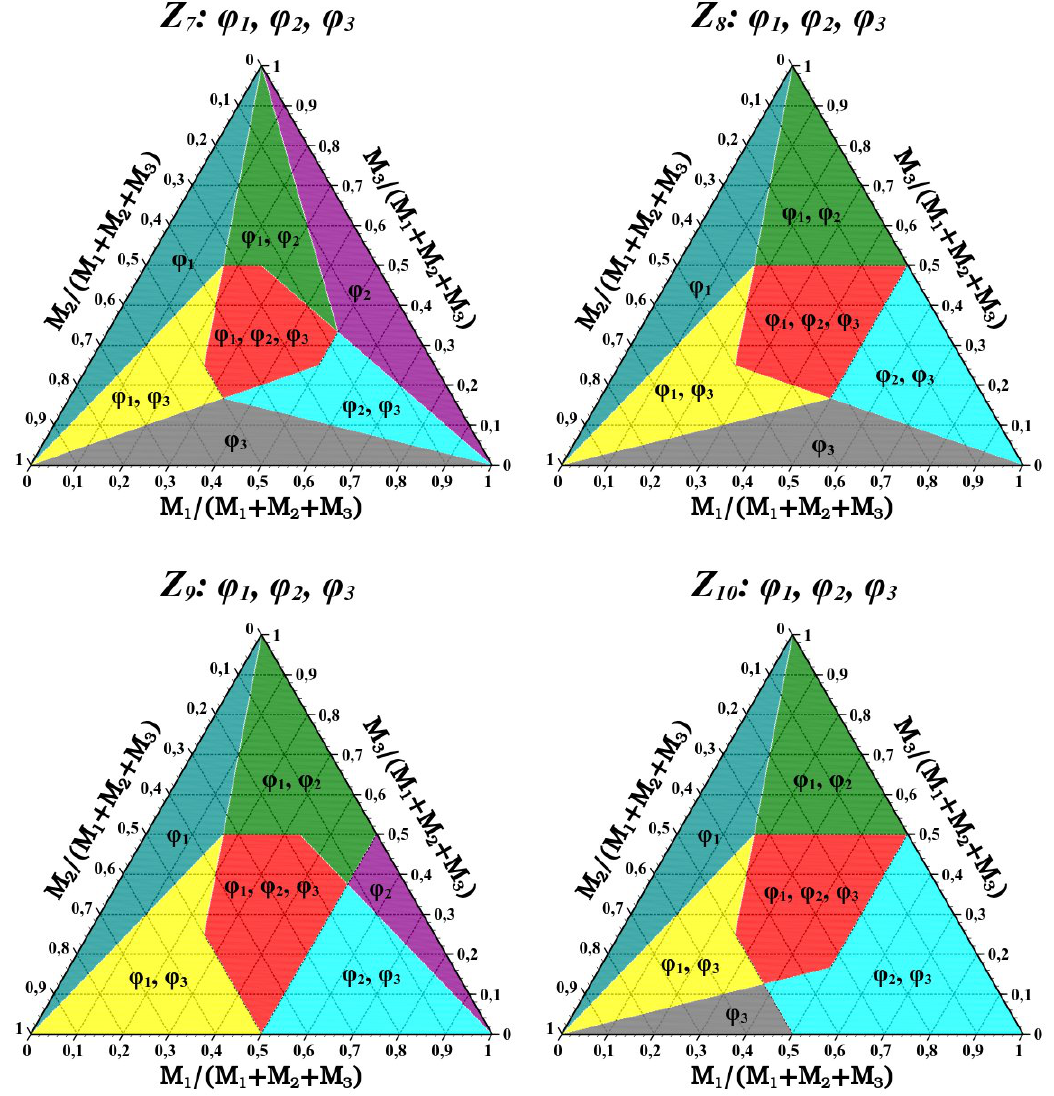
Figure 2 . Stability regions for a Z 7 (top left panel), Z 8 (top right panel), Z 9 (bottom left panel) and Z 10 (bottom right panel) symmetry with (cid:12)elds (cid:30) 1 ; (cid:30) 2 ; (cid:30) 3